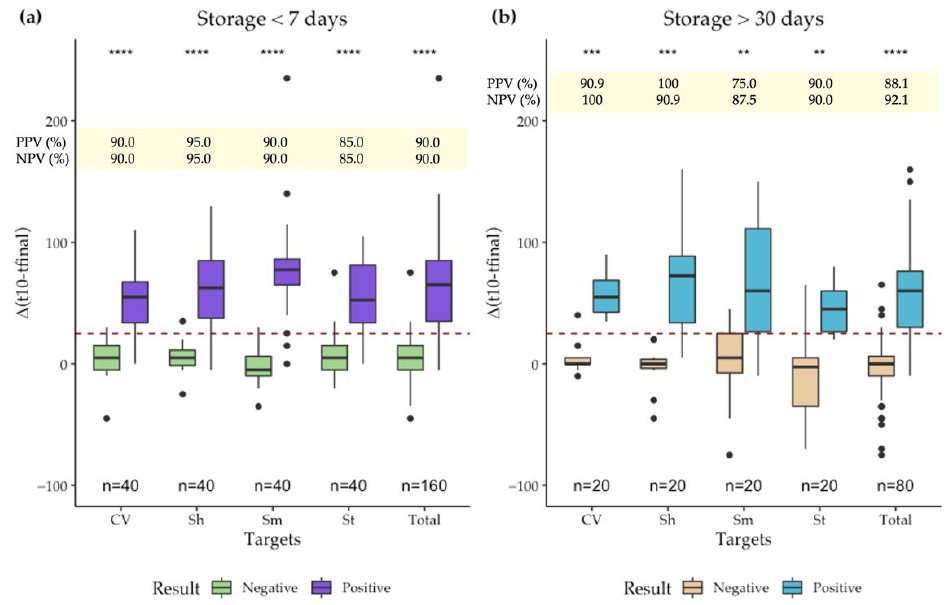
Figure 4. PTC and NTC analyzed with the SMART-LAMP for different dry-LAMP assays and storage times: ( a ) Differences between values of the R component of RGB 10 min after the start of the reaction and final value at reaction-end for different LAMP assays stored less than 7 days at RT after desiccation; ( b ) Differences between values of the R component of RGB 10 min after the start of the reaction and final value at reaction-end for different LAMP assays stored over 30 days at RT after desiccation. In yellow boxes, positive predictive values (PPV) and negative predictive values (NPV) of the SMART-LAMP are indicated. Targets: SARS: SARS-CoV-2; Sh: S. haematobium ; Sm: S. mansoni ; St: Strongyloides spp . Mann-Whitney U test: n/s: non-significant, *: p - value ≤ 0.05, **: p - value ≤ 0.01, ***: p - value ≤ 0.001, ****: p - value ≤ 0.0001.